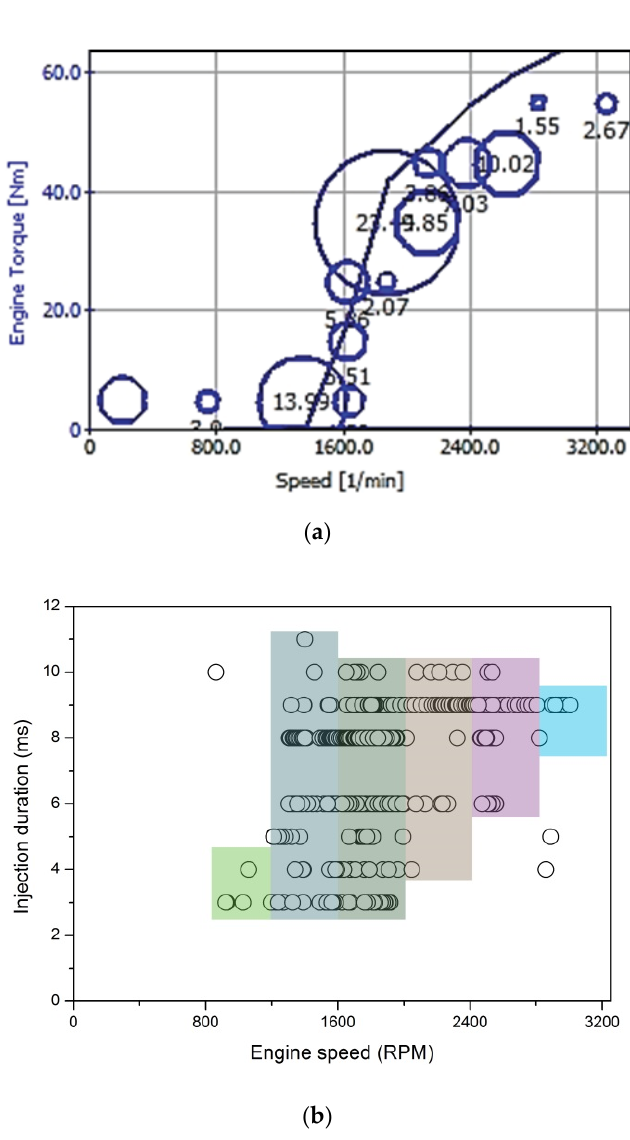
Figure 7. Comparison of engine torque in the numerical simulation with the fuel-injection duration obtained by experiment: ( a ) engine torque (CRUISE analysis); ( b ) fuel-injection duration. Table 4. Scenarios for engine-torque variation with fixed battery capacity in the numerical analysis.